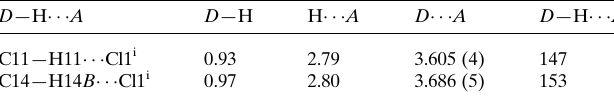
Table 1 Hydrogen-bond geometry (A˚ , (cid:5) ).